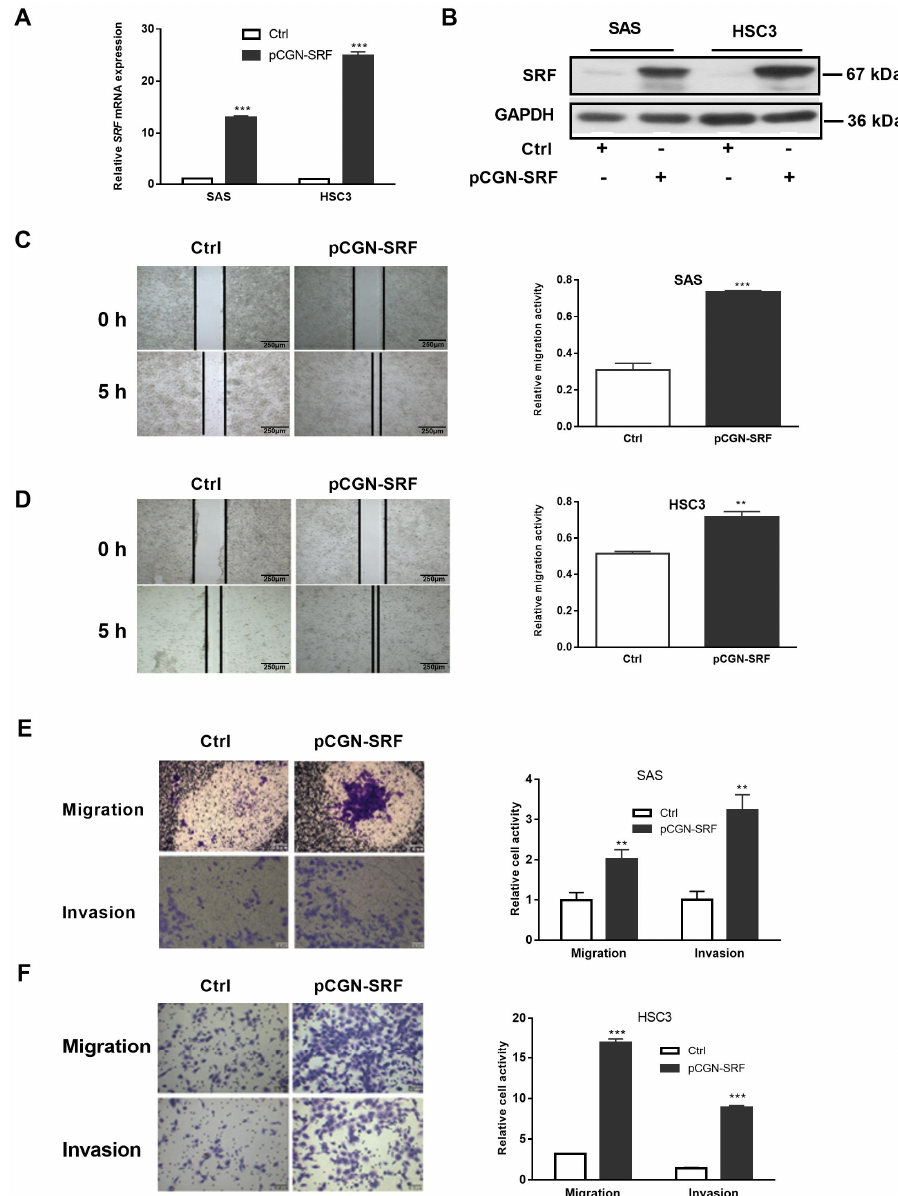
Figure 2. Overexpression of SRF facilitates OSCC cell migration and invasion. Serum-starved OSCC cells (SAS and HSC3) were transfected with pCGN-SRF or control vectors. The expression of SRF mRNA and protein were detected by performing qRT-PCR ( A ) and western blotting ( B ), respectively, at 36 h after transfection. The loading control was GAPDH. Original western blots are shown in Figure S5. Wound healing scratch assays of the migration capacity of SAS ( C ) and HSC3 ( D ) cells transfected with pCGN-SRF or control vectors. Surfaces of confluent cells were scratched 12 h after transfection. Left, representative images at 0 and 5 h after scratching. Right, quantitation of cell migration capability. Scale bar: 250 µ m. Migration and invasion capacity of SAS ( E ) and HSC3 ( F ) cells transfected with pCGN-SRF or control vectors using Transwells. Left, representative images; scale bar: 0.5 µ m. Right, quantitation of cell migration and invasion capability. Data are representative of three independent experiments. ** p < 0.01, *** p < 0.001 vs. control. Ctrl, control; OSCC, oral squamous cell carcinoma; qRT-PCR, quantitative reverse transcription-polymerase chain reaction; SRF, serum response